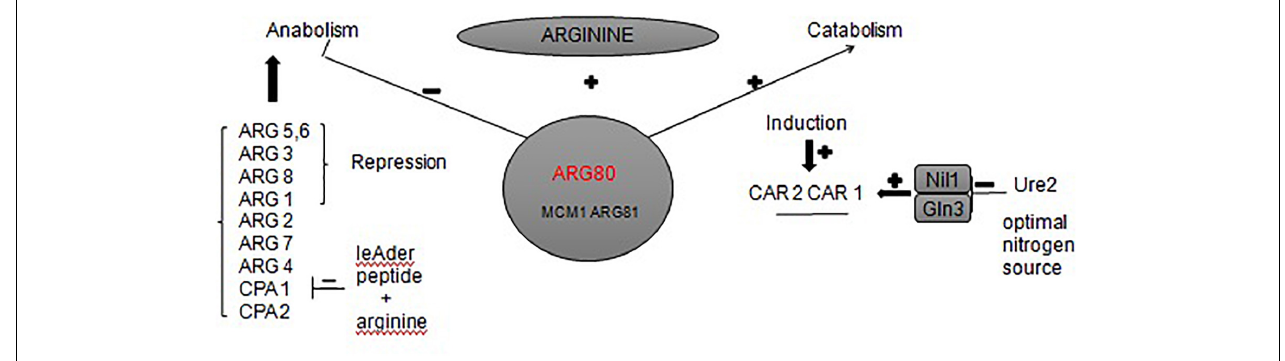
FIGURE 6 | Network of regulatory circuits controlling the arginine anabolic and catabolic genes in response to nitrogen